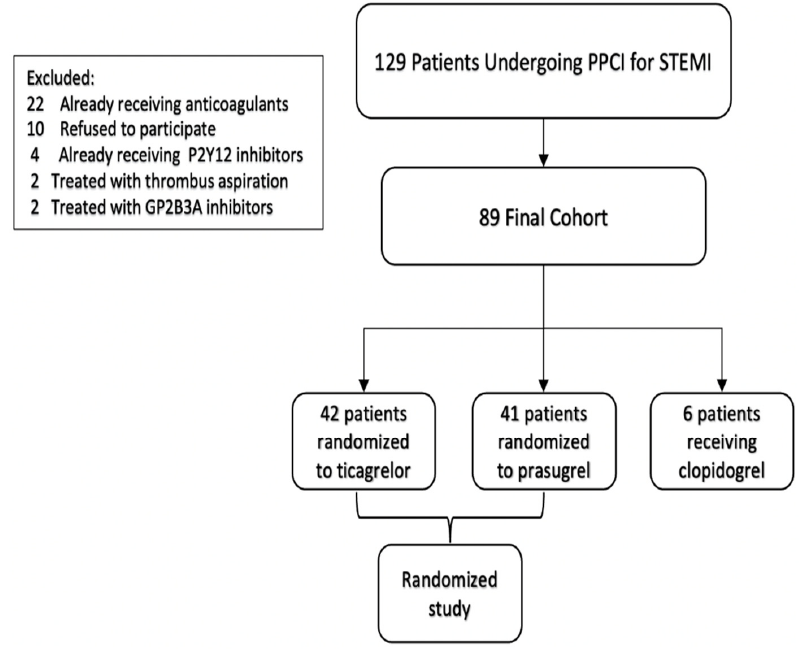
Figure 1. Study flow diagram.